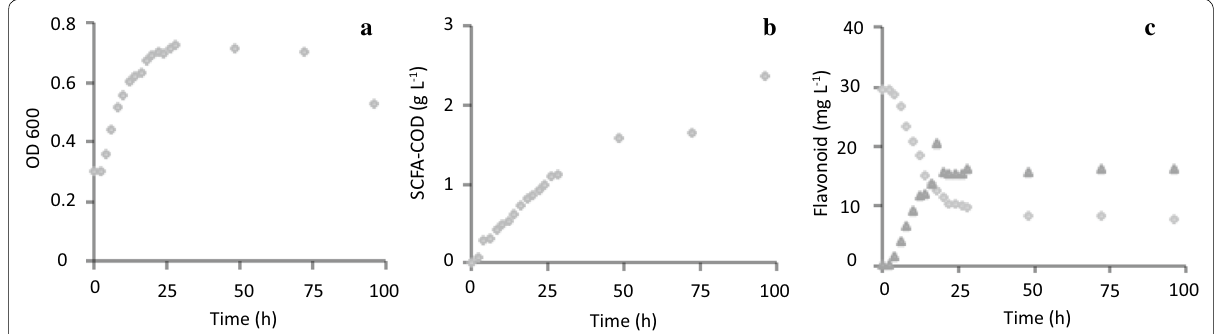
Fig. 2 Course of growth ( a ), basic metabolism, i.e., production of acetate and butyrate summed as chemical oxygen demand (COD) ( b ), and conversion of pure IX at 30 mg IX L − 1 (rhombi: IX; triangles 8-PN) ( c ) during growth of Eubacterium limosum in reinforced clostridial medium at 37